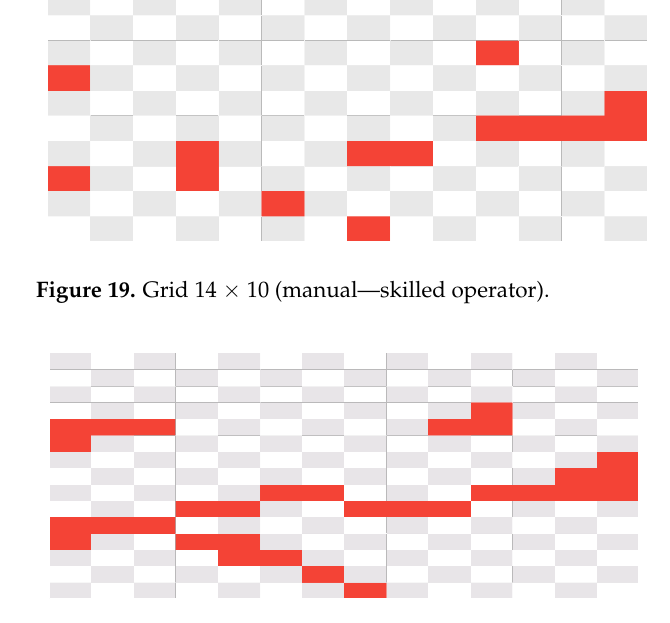
Figure 18. Reference XY-section of the stone block.